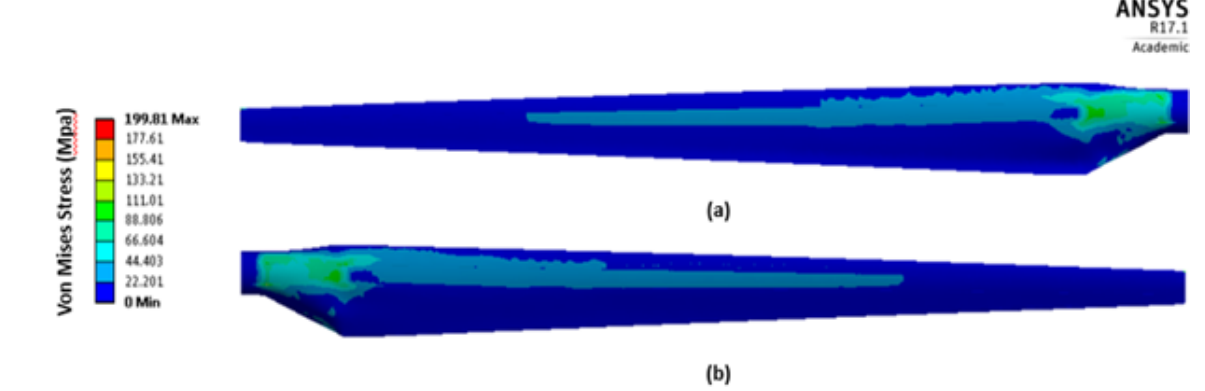
Figure 13. Contour plots showing the von Mises (equivalent) stress from the FEA model of the full-scale wind turbine blade under the defined